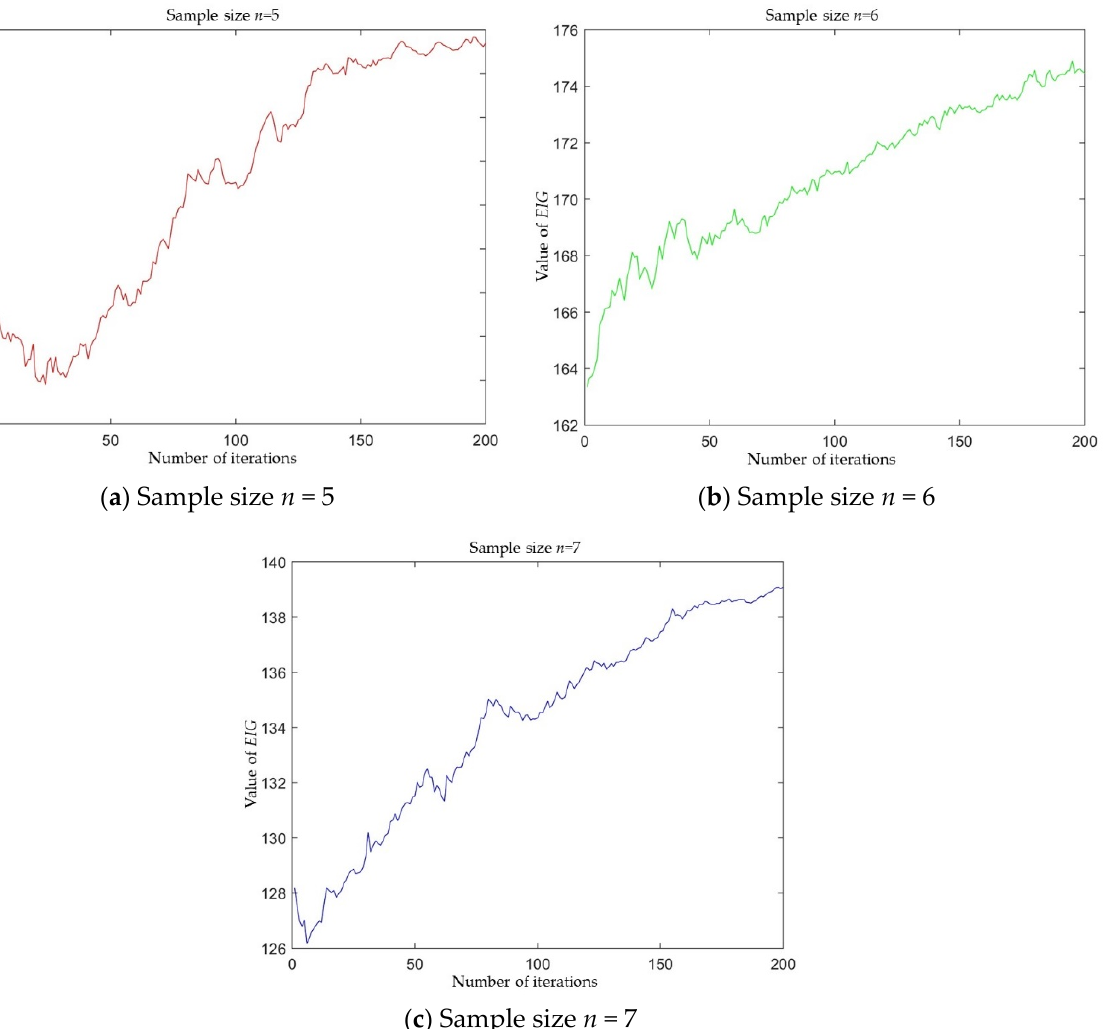
Figure 6. Iterative process of the optimal solution of pre-test optimization Table 7. The optimal test plan of pre-test optimization( n = 5, n = 6)